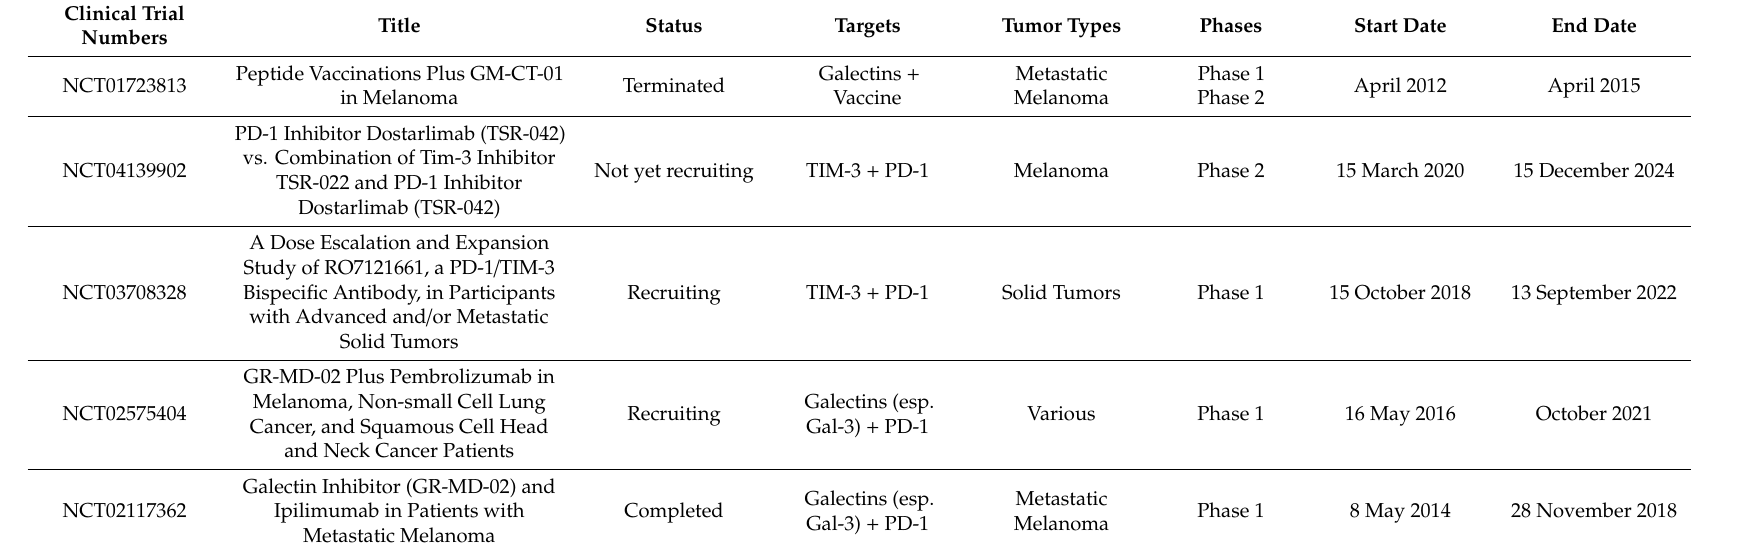
Table 6. Clinical trials involving the combination of immune checkpoint (ICP) and galectin- mediated